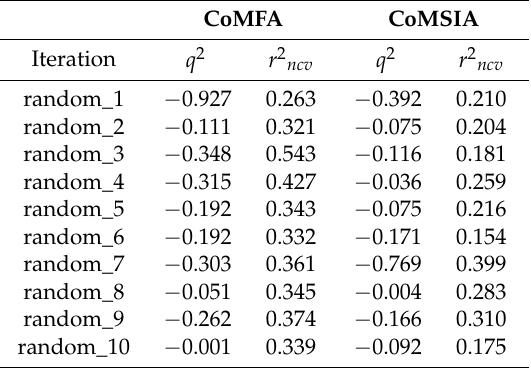
Figure 2. Plots of experimental versus predicted pEC 50 values for the training and test set molecules for CoMFA ( A ) and CoMSIA ( B ) models. Residual plots between predicted and experimental values for CoMFA ( C ) and CoMSIA ( D ); CoMFA ( E ) and CoMSIA ( F ) predictions for every molecule in the complete set. Table 4. q 2 and r 2 ncv values after several Y-randomization tests.